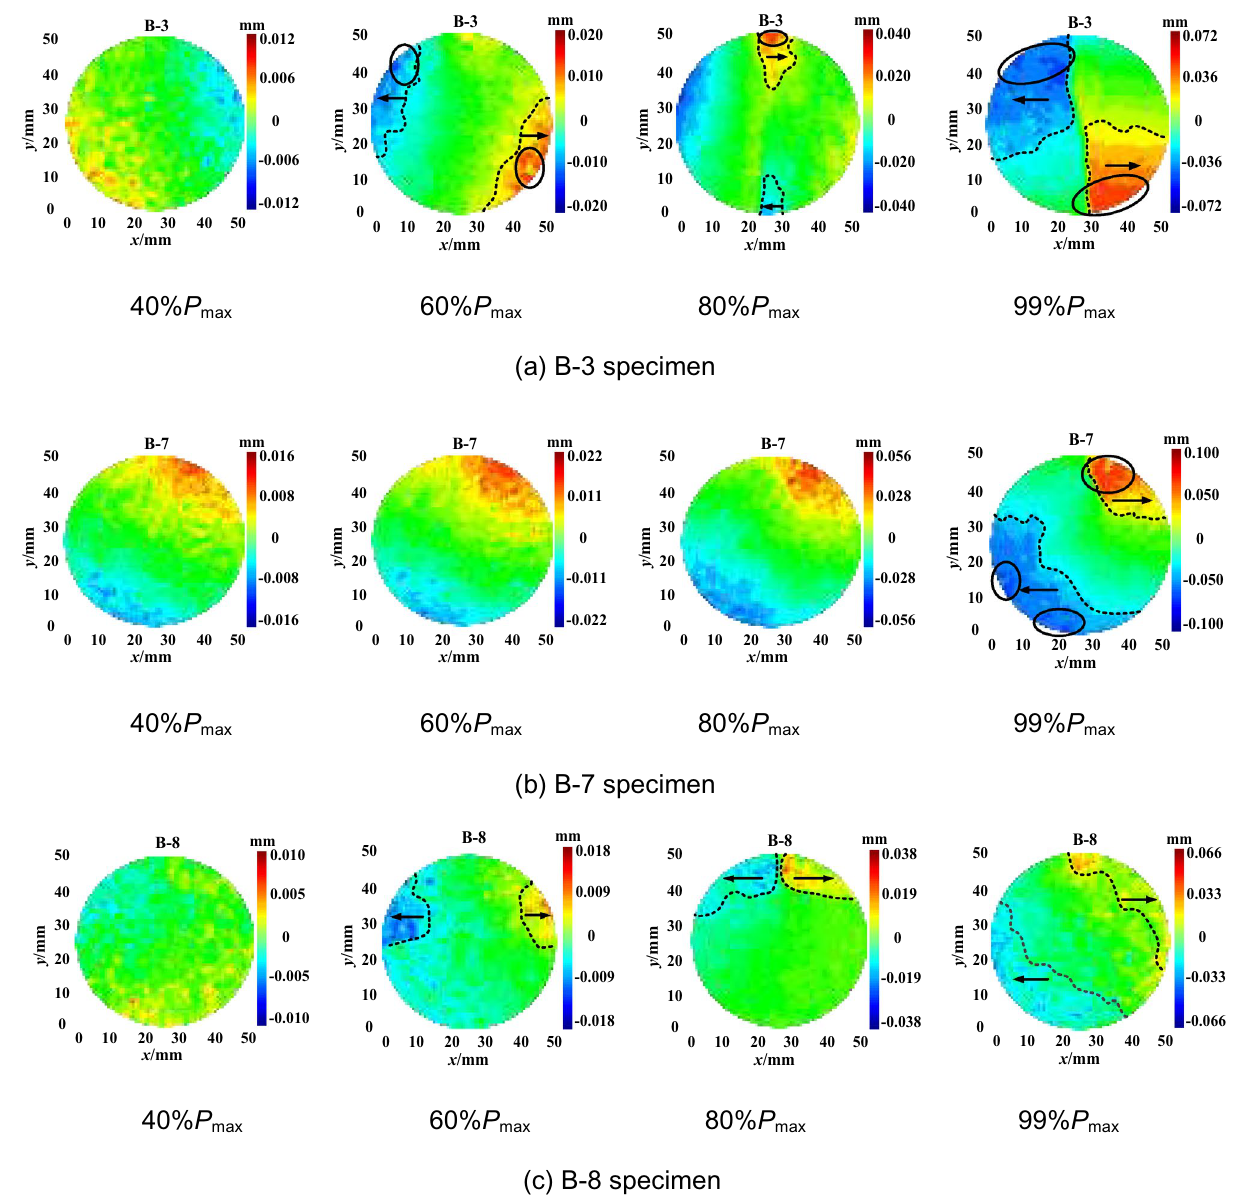
Figure 6. Horizontal displacement field of central